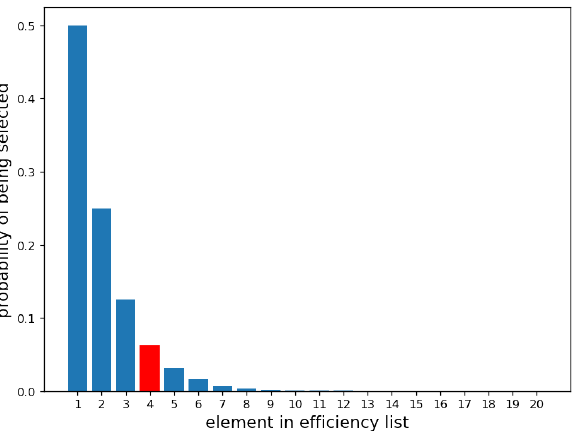
Figure 3. Biased random sampling of elements from a list using a geometric with p =